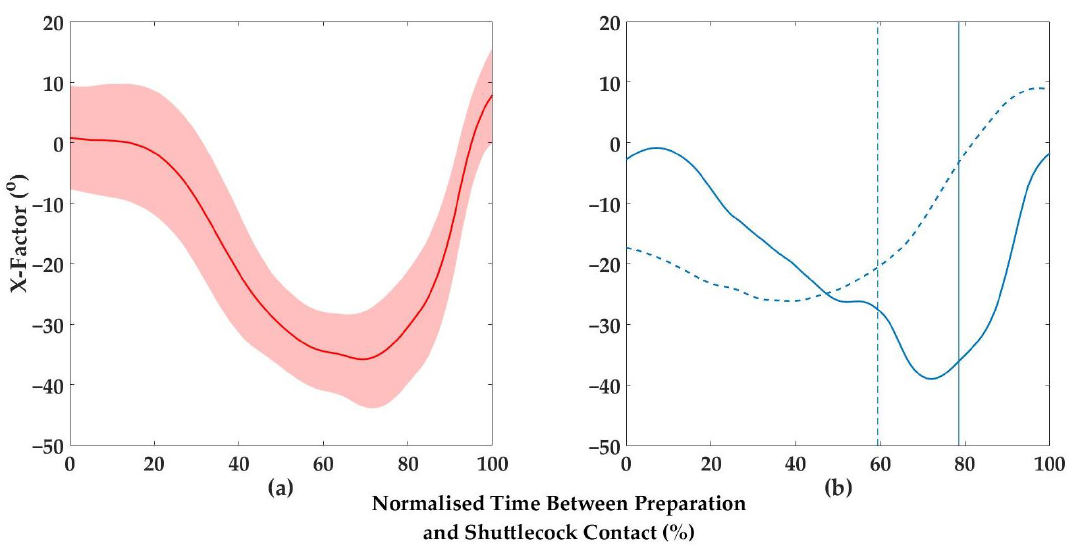
Figure 4. ( a ) Mean (solid line) ± SD (shaded area) for normalised X-factor between preparation and shuttlecock contact key instants for all participants; ( b ) Normalised X-factor between preparation and shuttlecock contact key instants for participants with the fastest (solid line) and slowest (dashed line) smash. The end of retraction (ER) key instant for each participant is represented by a vertical line. X-factor at ER was significantly correlated with shuttlecock speed.